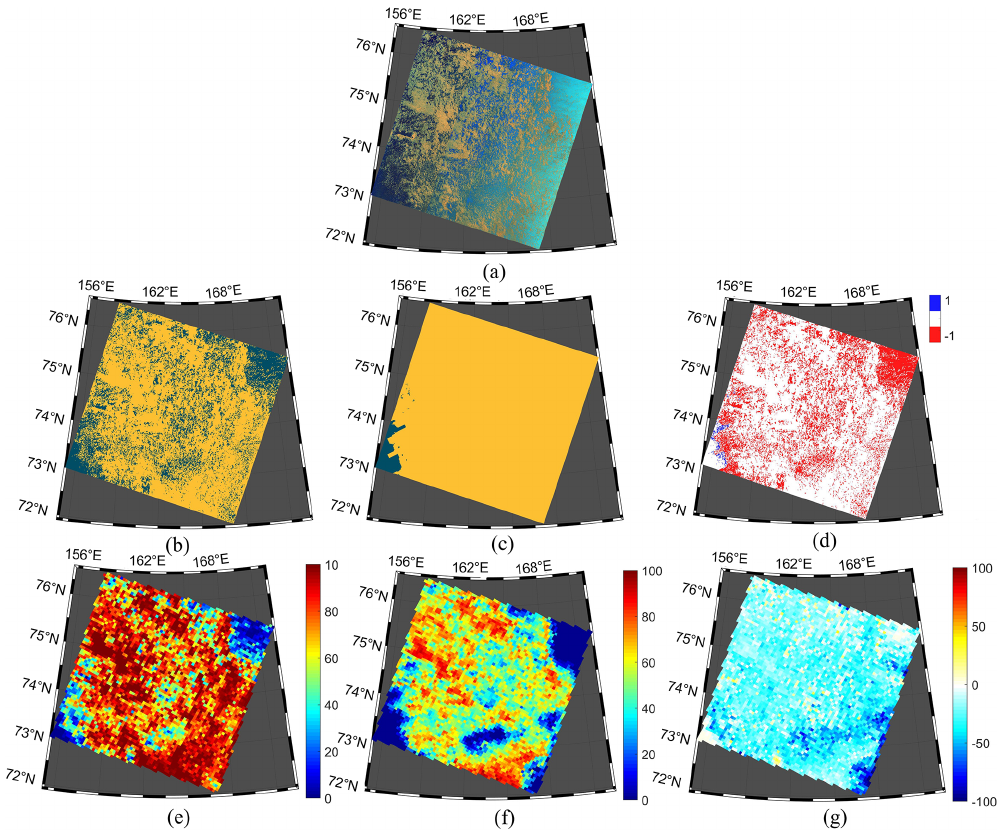
Figure 17. Example of the S1-derived sea ice cover acquired on 29 July and its comparison with the AMSR2 and IMS data. (a) RGB false-color composite image. Panels (b) and (c) are S1-derived sea ice cover and IMS sea ice cover, respectively. (d) Differences in the sea ice cover between the IMS and S1-derived results (IMS–S1). Panels (e) and (f) are S1-derived sea ice concentration and the AMSR2 data, respectively. (g) Differences in the sea ice concentration between the AMSR2 data and S1-derived results (AMSR2–S1). (Image